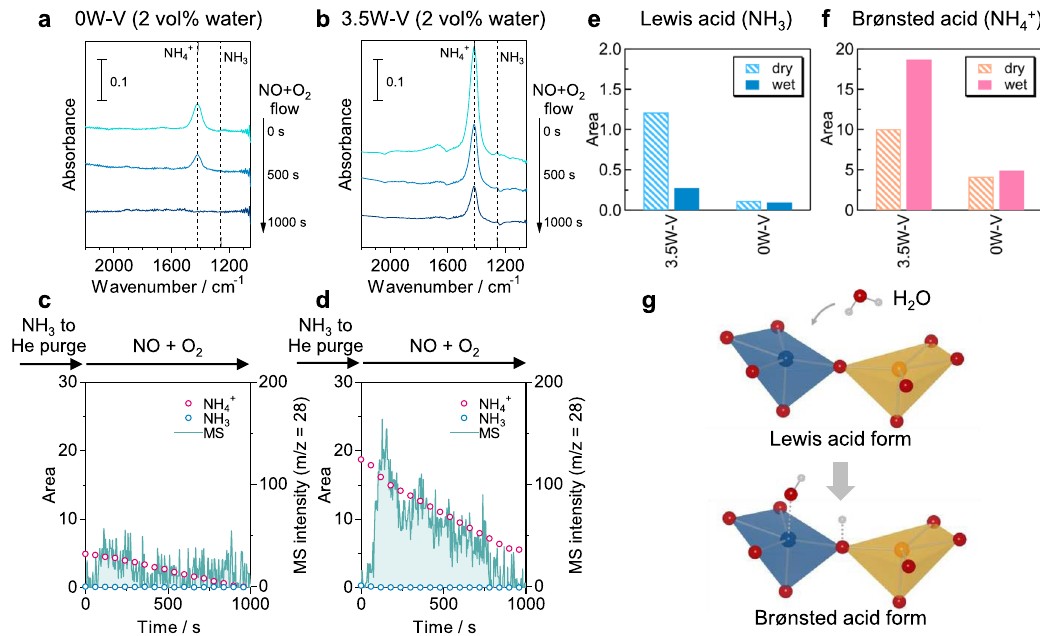
Fig. 8 Acid properties in the presence of water vapor. a , b Operando IR spectra of ad species on 0W – V (without tungsten) and 3.5W – V (with tungsten) during NH 3 adsorption, followed by NO + O 2 exposure at 150 °C under a wet condition (2 vol% water). The IR disc was exposed to 0.1% NH 3 /He fl ow (30 min) and purged with He (20 min), followed by exposure to 500 ppm NO + 8% O 2 + 2% H 2 O (He balance) fl ow. c , d The IR peak areas of NH 3 adsorbed on Lewis acid sites (NH 3 ) and Brønsted acid sites (NH 4 + ) and MS intensity of N 2 versus time of NO + O 2 fl owing. IR areas for e Lewis acid and f Brønsted acid measured from IR spectra (0 s) under dry and wet conditions. g Metal-exposed surface of W-substituted vanadium oxide and its changes from Lewis acid form to Brønsted acid form. Orange polyhedra: vanadium units; blue polyhedra: tungsten